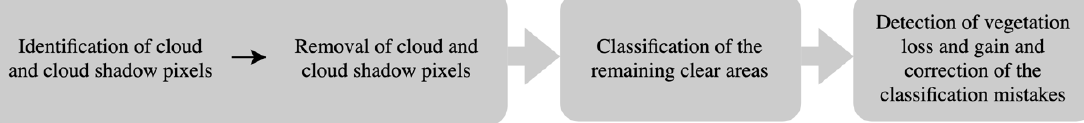
Figure 4. Two-step automated classification strategy followed by false positive correction and vegetation evolution analysis.